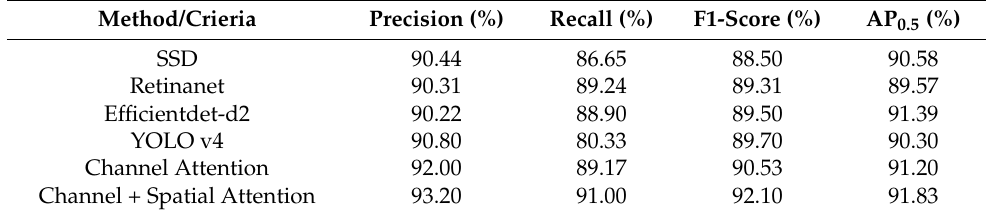
Table 7. Comparison of attention mechanism ablation